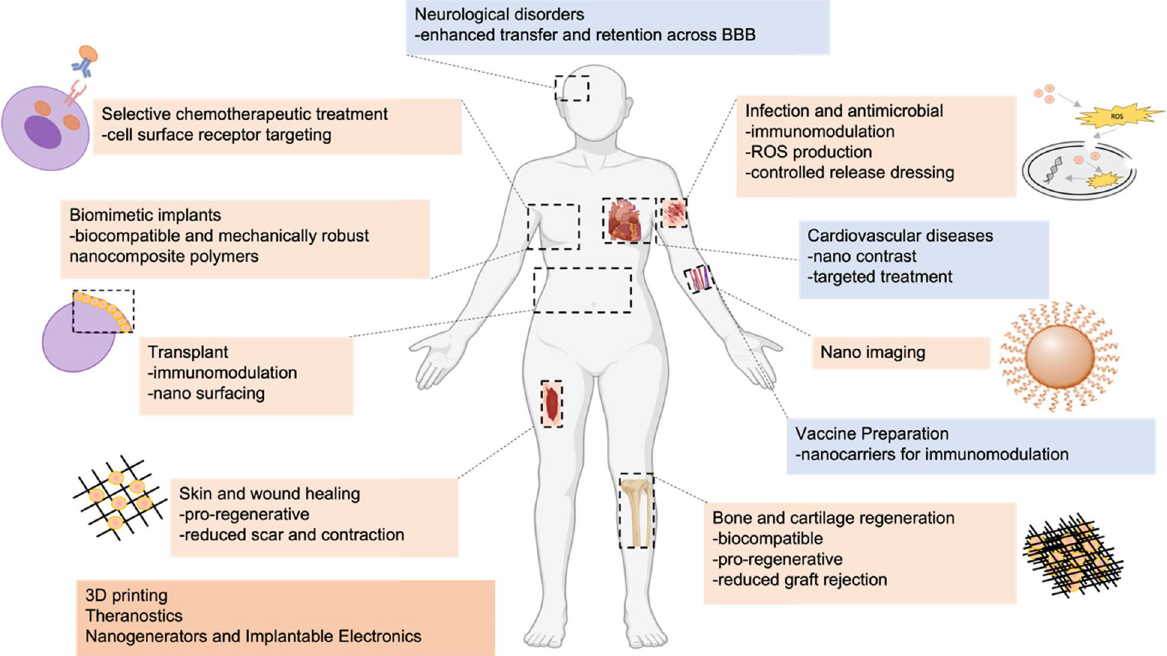
Fig. 1 Schematic of nanobased drug delivery applications in facial plastics and reconstructive surgery (PRS), and other fields of medicine. PRS applications are in light orange, while applications to other fields of medicine are in light blue. Figure partially created in Microsoft Powerpoint and BioRender (https:// biore nder.